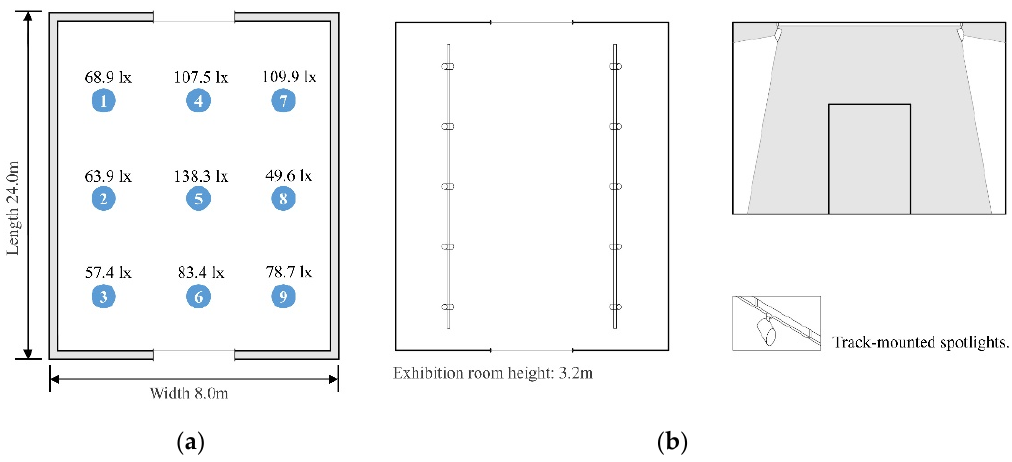
Figure 5. The national museum of western art building interior. ( a ) Illuminance plane spot test. ( b ) The arrangement and elevation of the direct lighting display source.